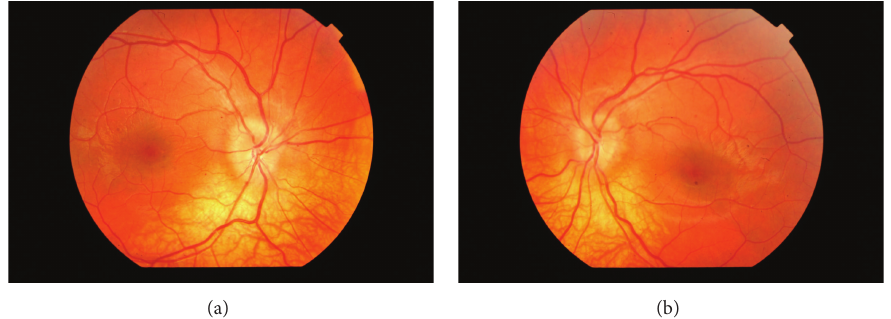
Figure 1: ((a), (b)) Bilateral optic disc edema on initial examination. There is elevation of nasal and temporal circumference of the optic nerve with a halo surrounding the disc completely.